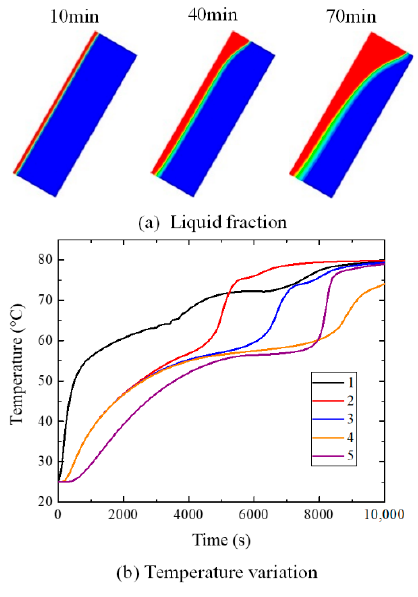
Figure 13. The melting process of paraffin at 120°. ( a ) Liquid fraction; ( b ) temperature variation.